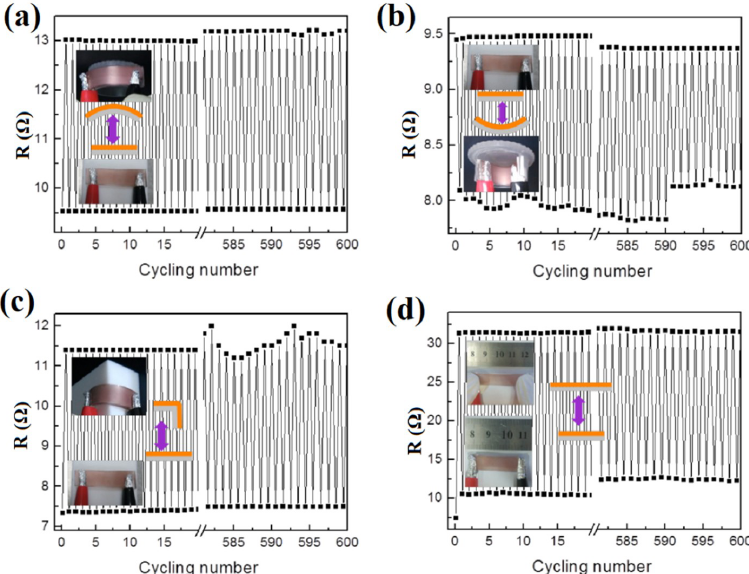
Figure 14. Changing the resistance of the composite film of Cu NW/AZO: ( a ) tensile bending with curvature radius of 25 mm; ( b ) compressive bending with curvature radius of 23 mm; ( c ) vertical bending; and ( d ) 20% stretching‐releasing process. Reproduced with permission from [51]. Copyright 2014 ACS Publishing.